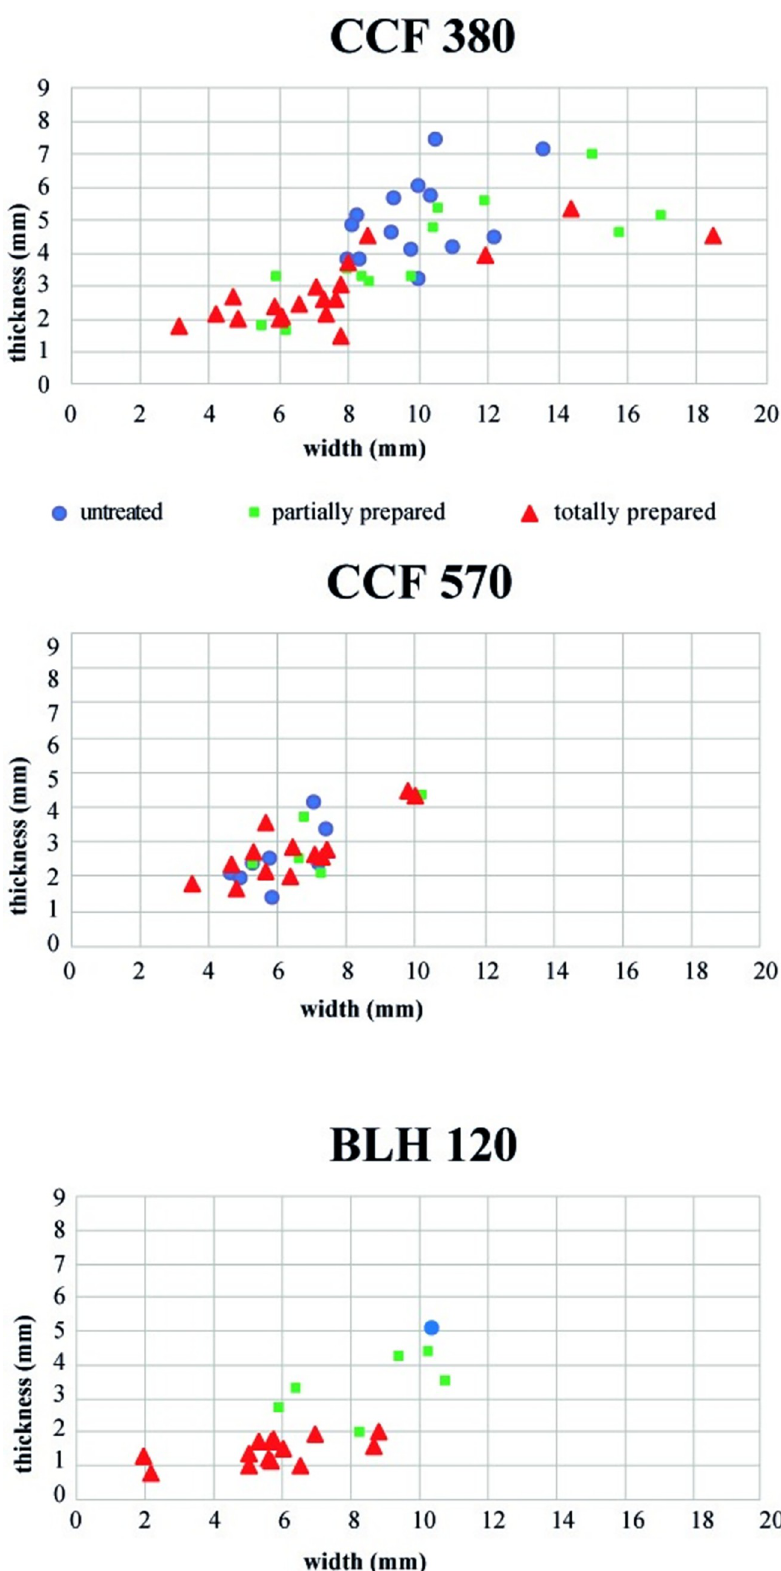
Fig 6. Diagrams of the distribution of width and thickness of butts by type of overhang preparation per house. https://doi.org/10.1371/journal.pone.0268442.g006 PLOS ONE | https://doi.org/10.1371/journal.pone.0268442 June 1,